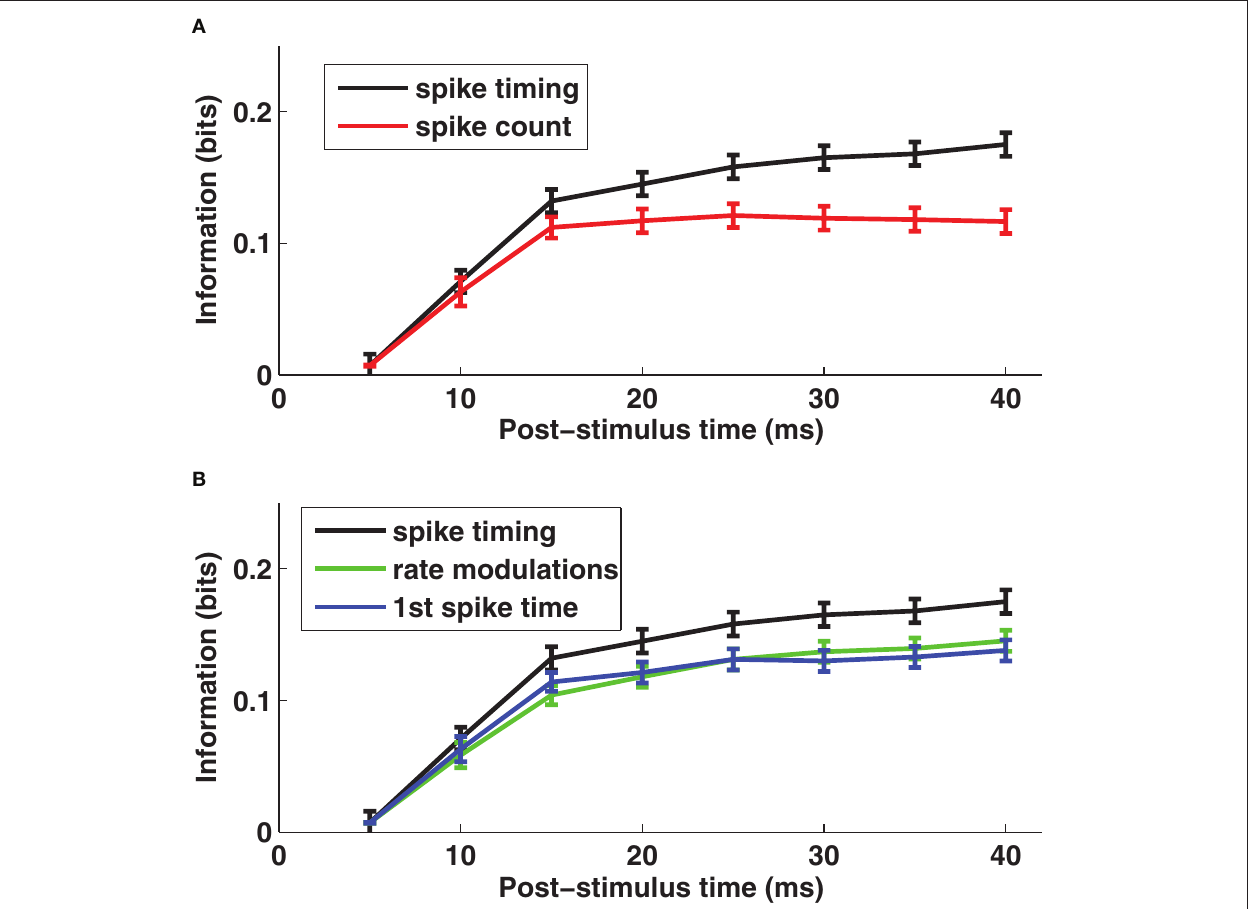
Figure 1 | The encoding of stimulus location by single neuron spike times with knowledge of external clock. (A) The post-stimulus time course of the information about stimulus site available from two different neural codes provided the decoder knows stimulus time. Results are plotted as average ( ± SEM) across cells of the mutual information functions. The black line denotes the spike timing information obtained when sampling spikes with temporal resolution ∆ t = 5 ms, and the red line denotes the spike count